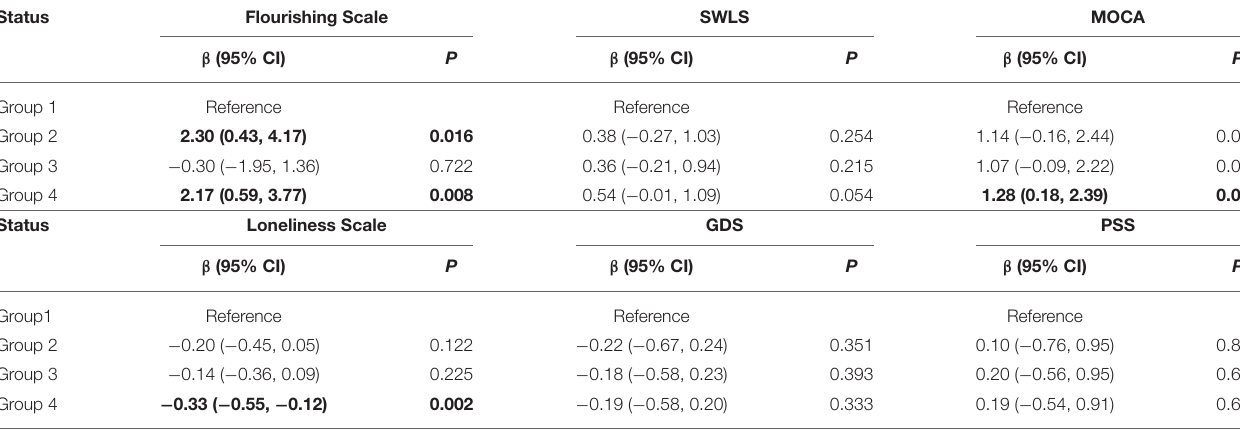
TABLE 2 | Result of multiple linear regression for mental health